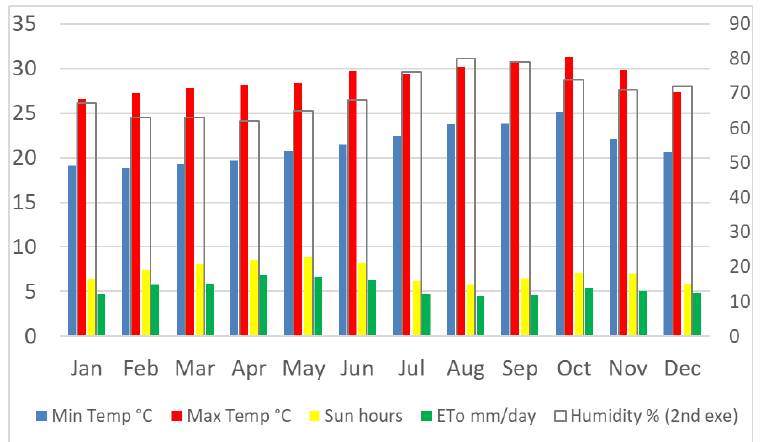
Figure 1. Monthly minimum temperatures (Tm), maximum temperatures (TM), reference evapotranspiration, humidity and hours of sun. Data from Automatic weather station − 23.51° N 14.9° W, 27 m a.s.l. Praia, FAO, 2020. AQUASTAT (CLIMWAT 2.0 FAO).